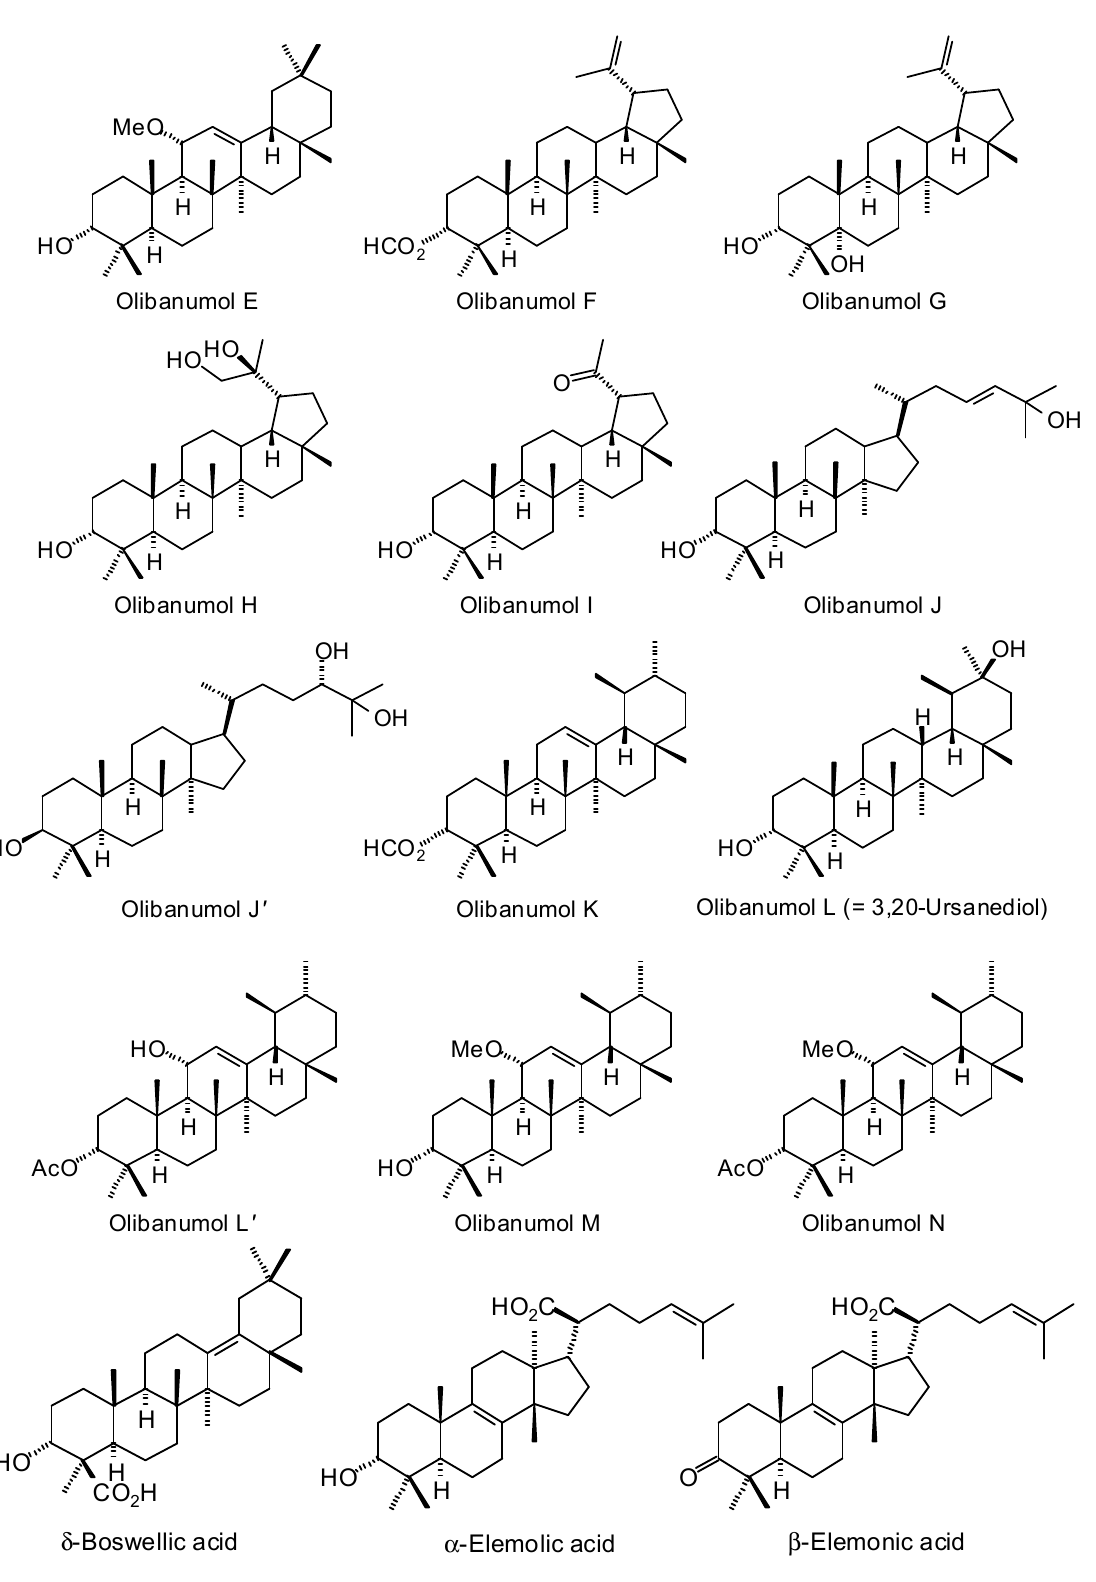
Figure 3. Triterpenoids isolated from Boswellia species.